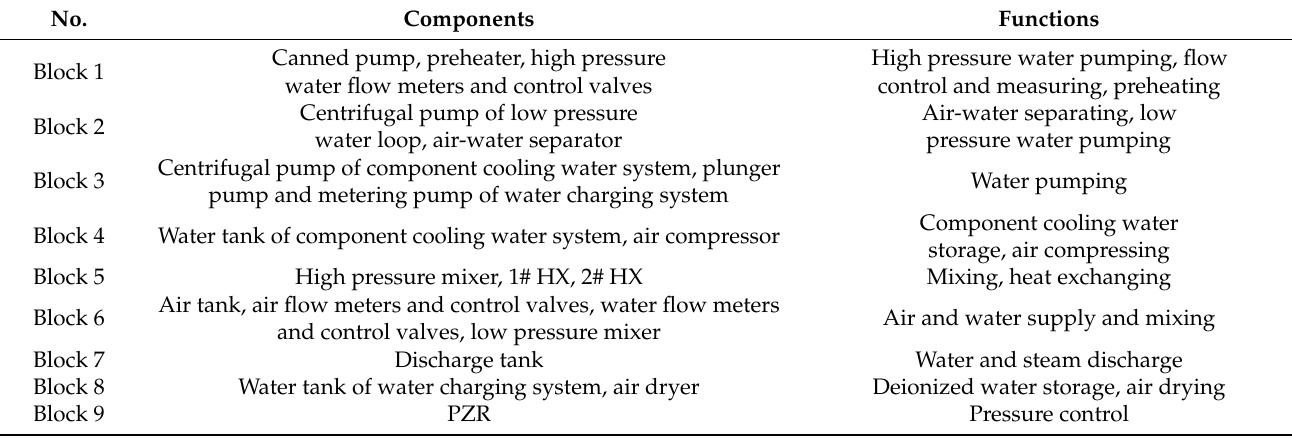
Figure 10. A 3D layout of the water loop in plant of CRAFT. Table 7. Information of Block 1–9 of the water loop.